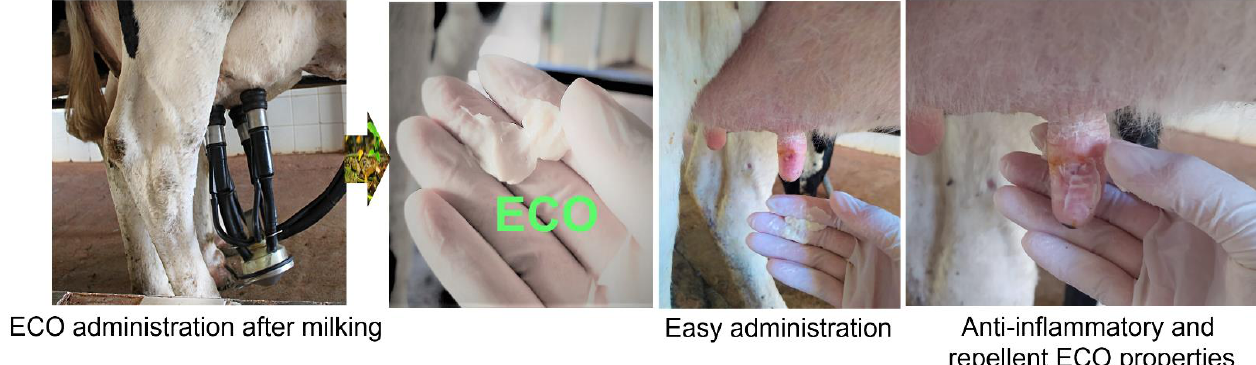
Figure 3. ECO administration after milking.